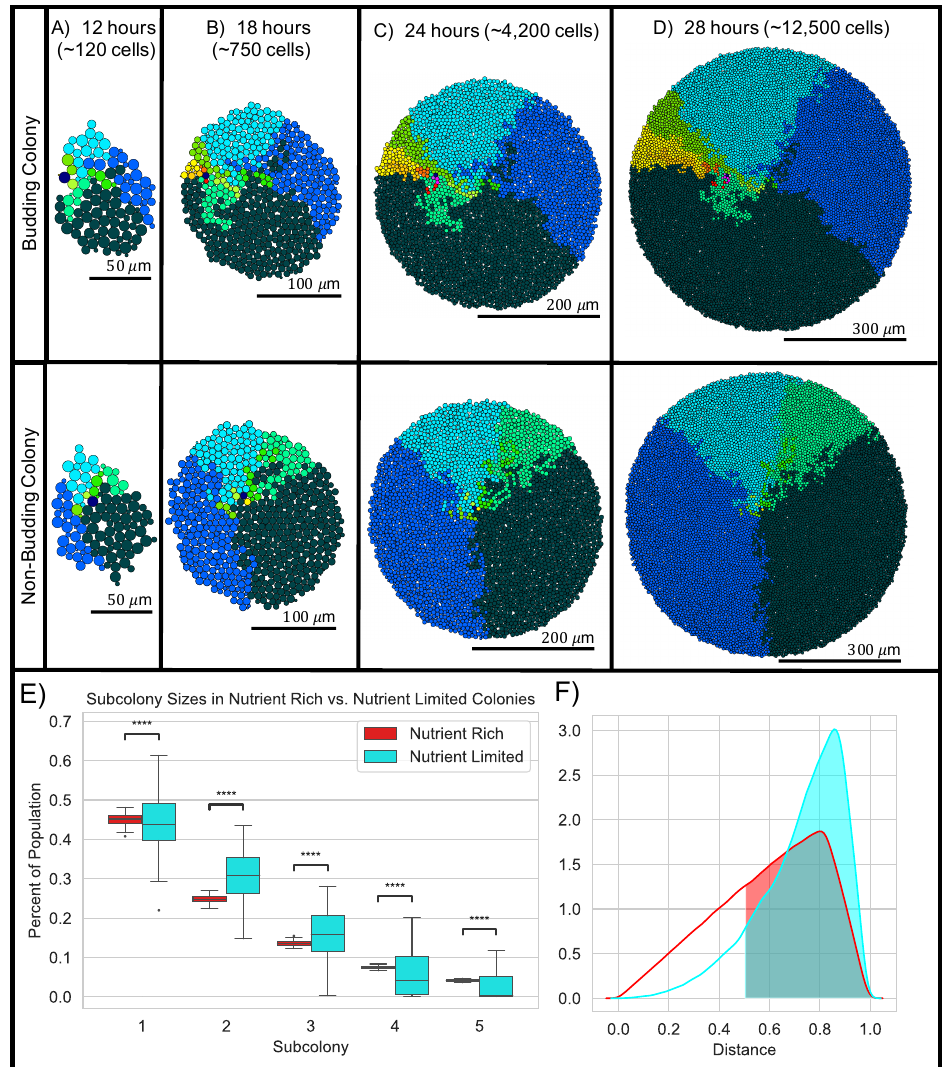
subcolonies that grow in a “sector-like” formation (compare Figure 11 (top and middle) with Figure 2 (middle and bottom)). Namely, subcolony boundaries in nutrient-limited simulations are more linear. This is especially visible in the last time point at 28 h.